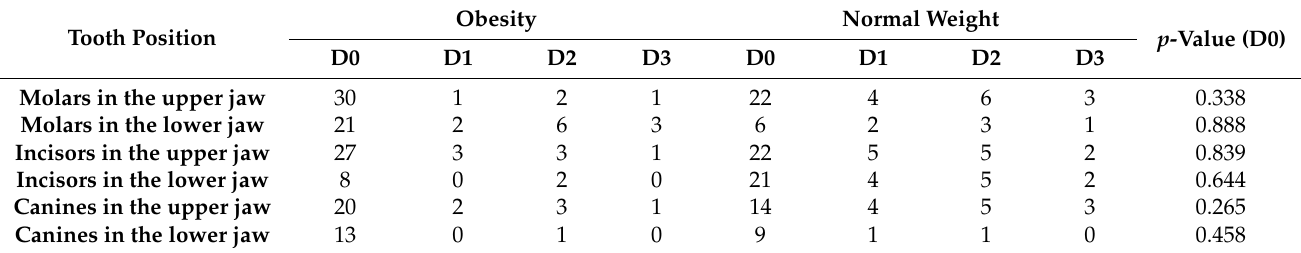
Table 5. Effectiveness of treatment after 6 months by tooth